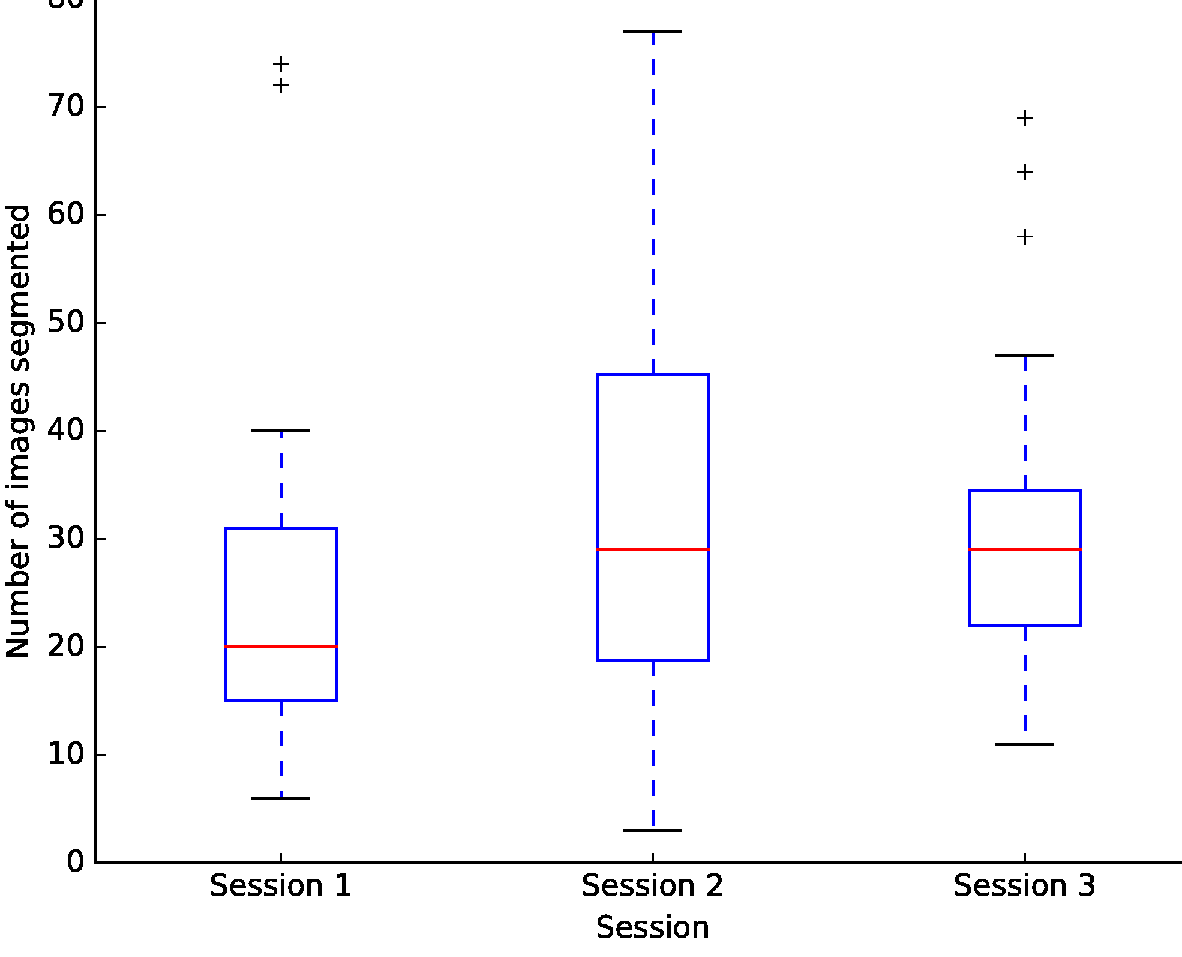
Fig 2. Number of images segmented by citizens at each session. Data is for all 29 citizen participants. Box plots show the median (red line), the lower to upper quartiles (blue boxes), range (dotted blue lines) and outliers (+ symbols).